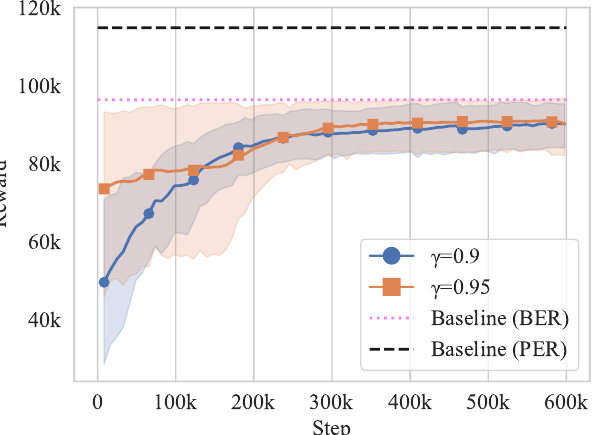
Figure 6. The system does not converge when using decision models to process information from the environment directly and make decisions.